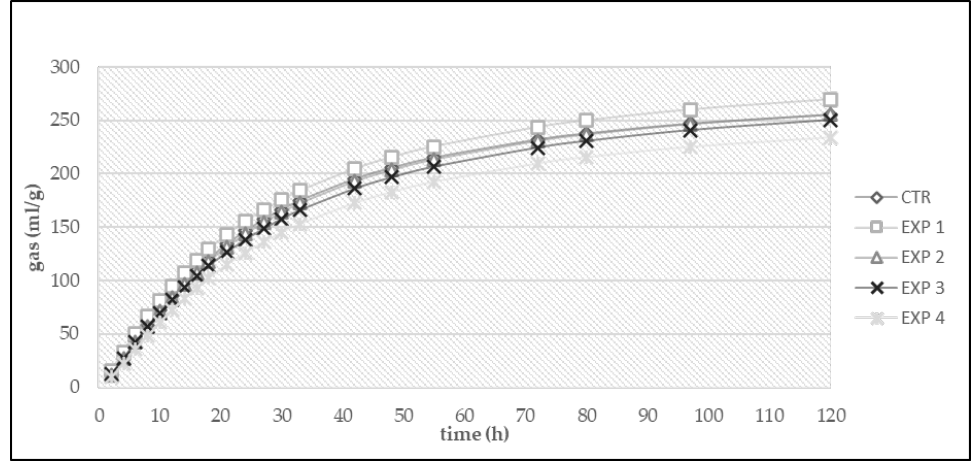
Figure 3. In vitro gas production over time in control and experimental diets with bovine inoculum.